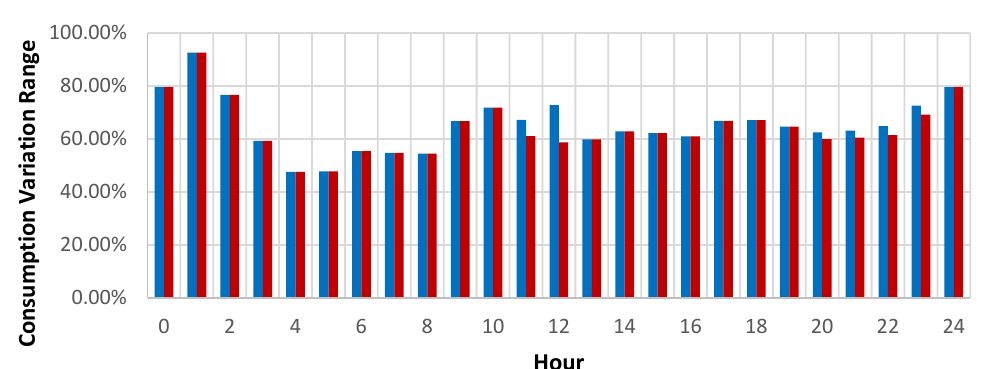
Figure 18. Energy consumption variation range compared to hourly average weekdays consumption for original and cleared data sets.